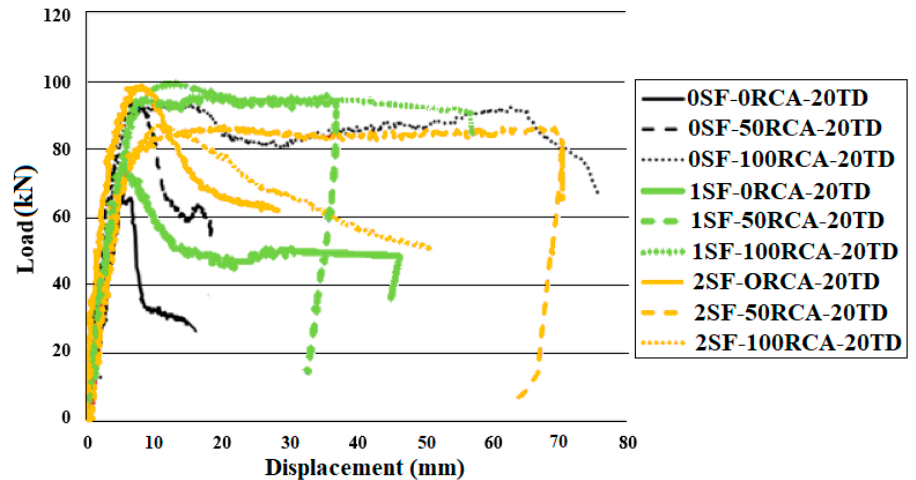
Figure 16. Bending behaviour of specimens with various SF and RA contents and 200 mm shear rebars’ spacing. 20TD: transverse reinforcement spacing 200 mm